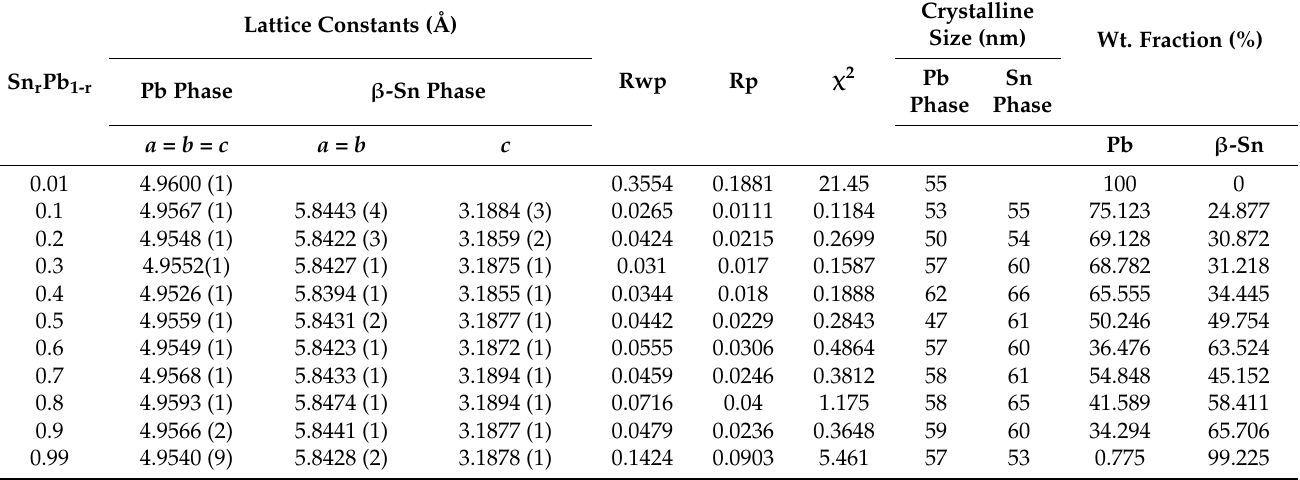
Table 1. Summary of best fitted Rietveld refined fitting parameters of the Sn and Pb phases from the Sn r Pb 1-r nanoalloys using the GSAS software package: lattice constant ( a , b , c ), weighted residue (Rwp), residual of least square refinement (Rp), a squared ratio between Rwp and Rexp ( χ 2 ), crys- talline size, and weight fractions (Wt.